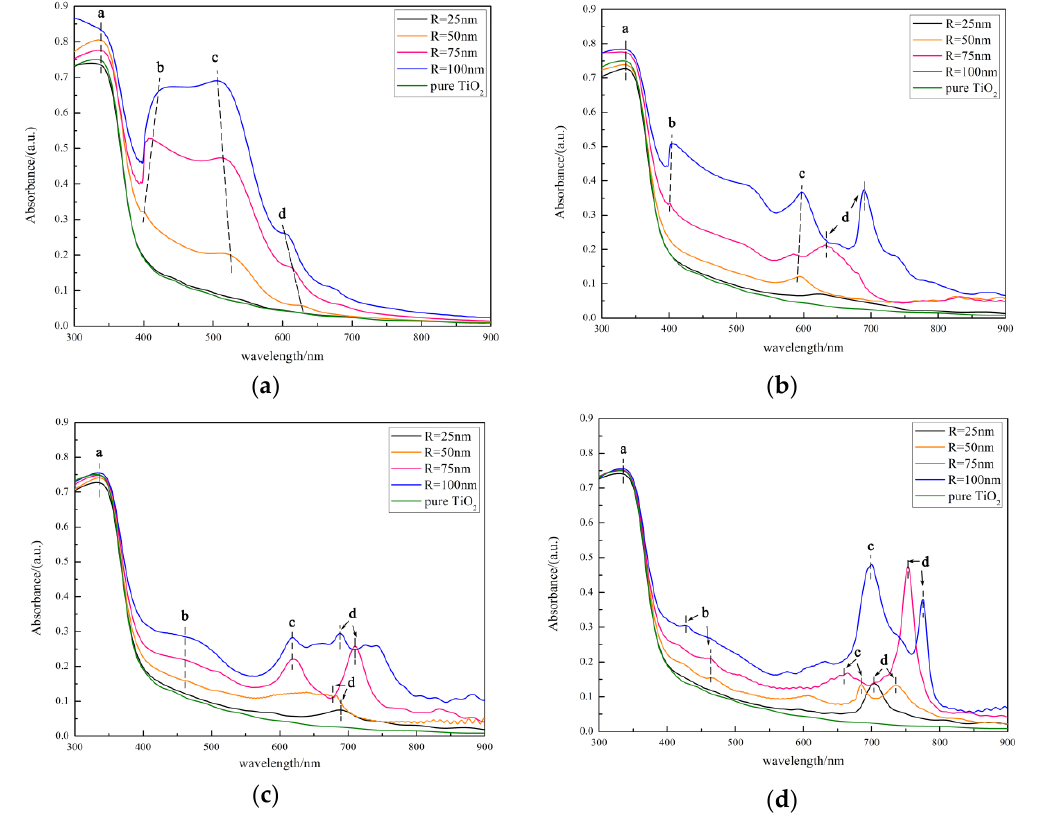
Figure 3. The absorption spectra of Au nanospheres loaded on the TiO 2 substrate with different radii and locations: ( a ) Model A; ( b ) Model B; ( c ) Model C; and ( d ) Model D as labeled in Figure 1.